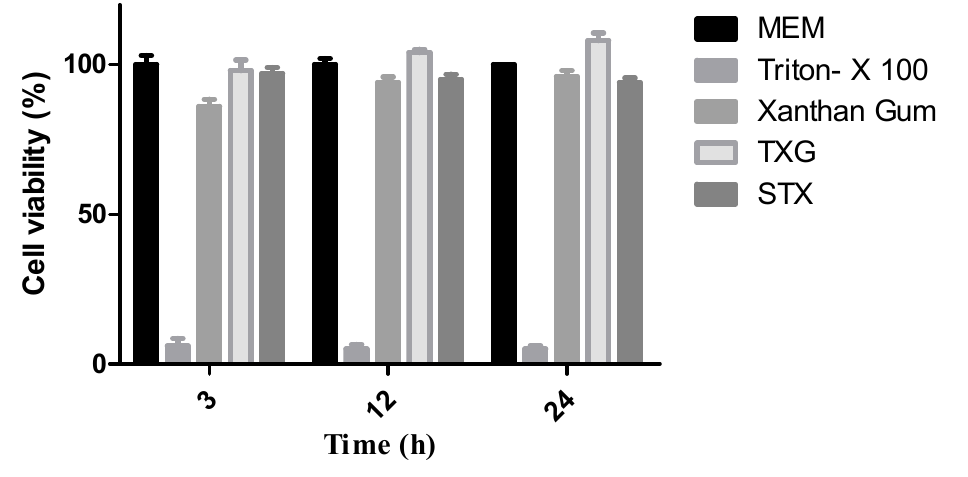
Figure 8. Cytotoxic studies.